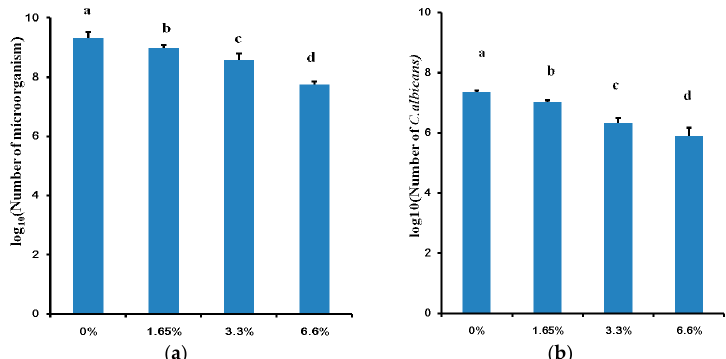
Figure 1. Colony forming unit (CFU) counts of multi-species biofilms: ( a ) The total CFU counts of 72 h multi-species biofilms in different dimethylaminododecyl methacrylate (DMADDM) containing groups; ( b ) The C. albicans CFU counts of 72 h multi-species biofilms in different group. Values are significantly different when labelled with different letters ( p < 0.05).